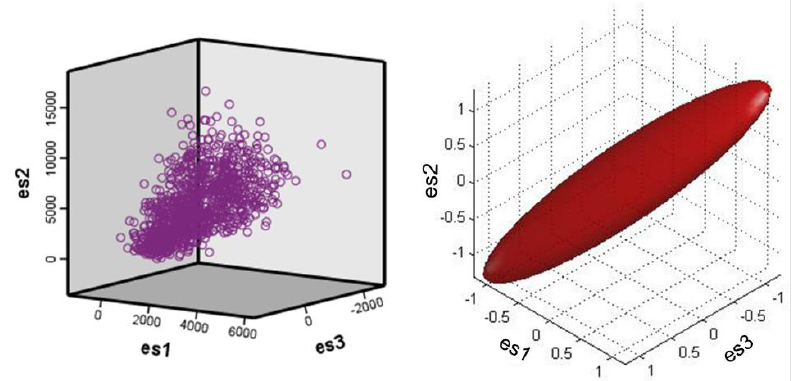
Figure 3. Scatter distribution in ES space ( left ) and ESST ellipsoid model ( right ).